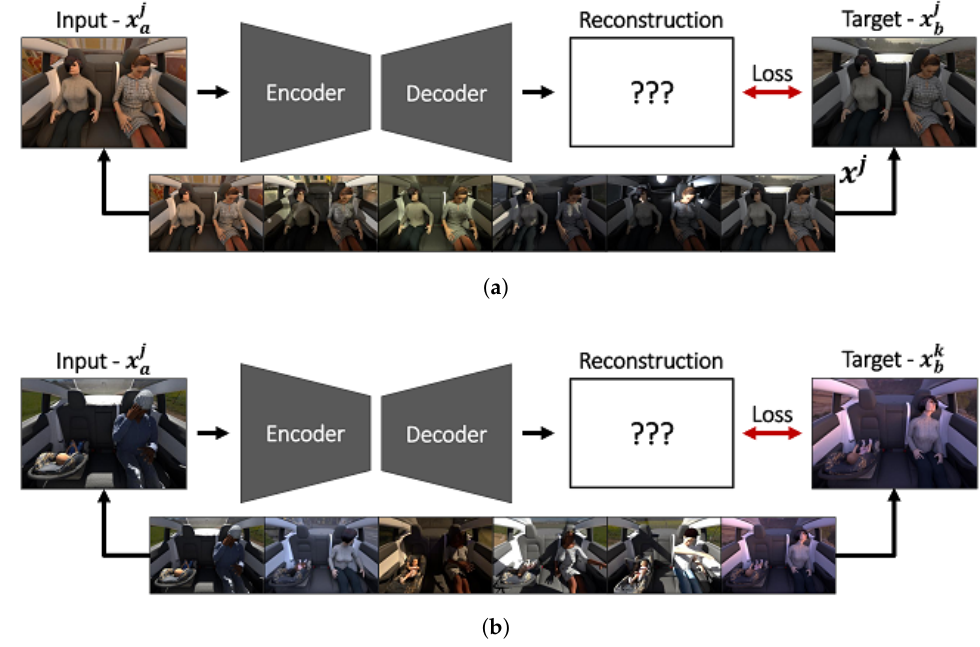
Figure 1. Illustration of an autoencoder model (encoder and decoder) using the two different partially impossible reconstruction losses together with sampling examples. ( a ) Variation I: input X j a and target X j are images of the same scenery X j , but under different illumination conditions. ( b ) Variation II: b for the input X j a a new scenery X k of the same class label is selected as b